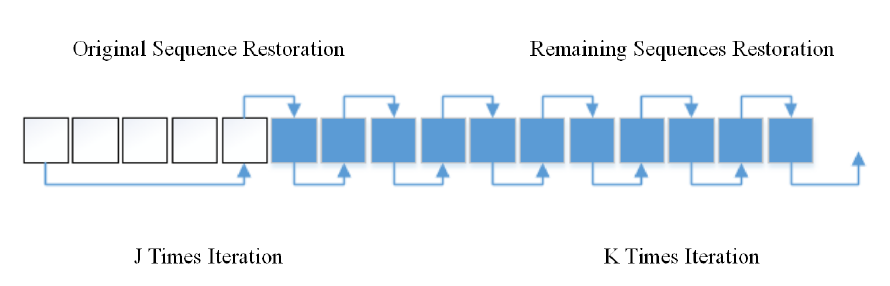
Figure 4. Two-step iterative algorithm. The iteration time J is greater than